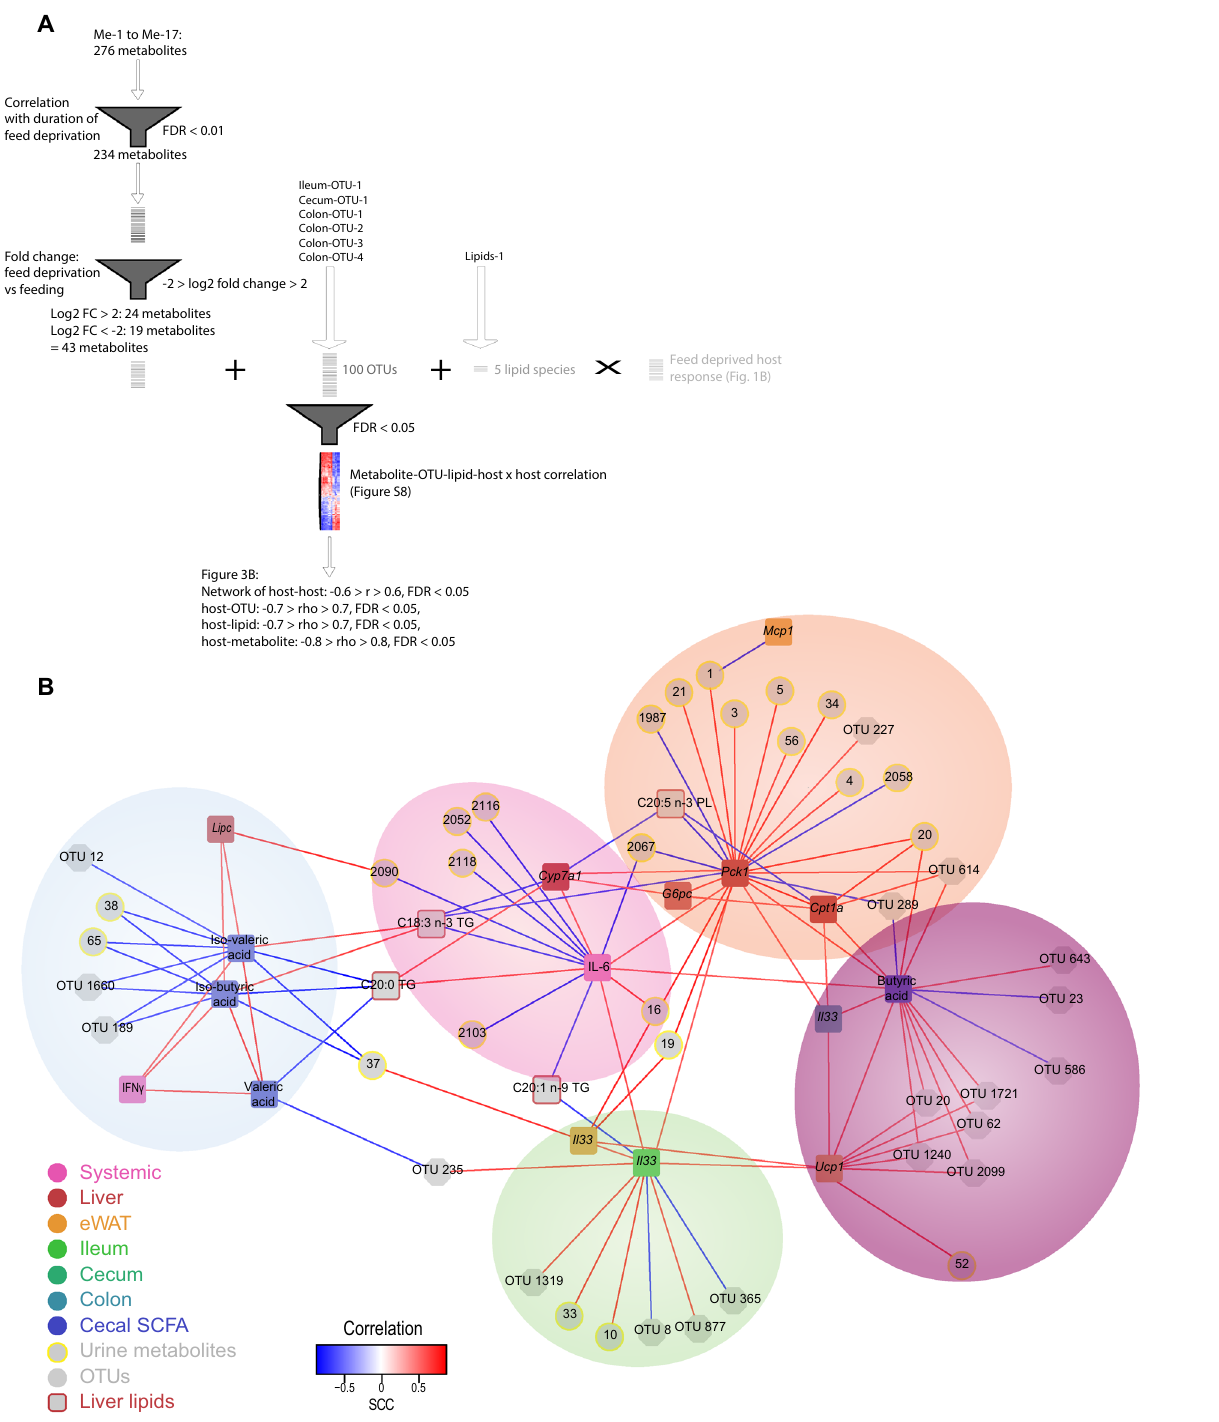
Figure 3. Combined network and multivariate correlation analysis to interlink feed deprivation-induced whole body parameters at the molecular level. ( A ) Step-wise approach to integrate the urine metabolome with the bacterial OTUs and liver lipids at the molecular level. All the 276 metabolites belonging to either of the 17 metabolite clusters (Me-1 to Me-17) were reduced by correlation with duration of feed deprivation (Spearman’s correlation, FDR < 0.01). The derived 234 metabolite features were similarly reduced by exclusion of metabolite features with log2 fold change < 2 and > − 2. The resulting 43 metabolites, all 100 OTUs belonging to any of the six feed deprivation-associated bacterial OTU clusters (Ileum-OTU-1, Cecum-OTU-1, and Colon-OTU-1 to -4) and the five liver-derived lipids present in the Lipids-1 cluster were subsequently correlated with the host response parameters associated with feed deprivation (Spearman’s correlation, FDR < 0.05). ( B ) Network analysis representing the resulting significant correlations (FDR < 0.05) from ( A ). Only host-metabolite correlations with rho > 0.8 or rho < − 0.8, host-OTU and host-lipid with rho > 0.7 or rho < − 0.7, and host-host correlations with rho > 0.6 or rho < − 0.6 are shown. The line color between nodes defines the correlational direction (red lines, positive correlations; blue lines, negative correlations). Identifiers for the 43 metabolites, 100 OTUs and 5 lipids are shown in Table S2A-C. The resultant five modules are shaded in individual colors (blue, green, orange, pink, purple). Node colors and shapes are representative of the data